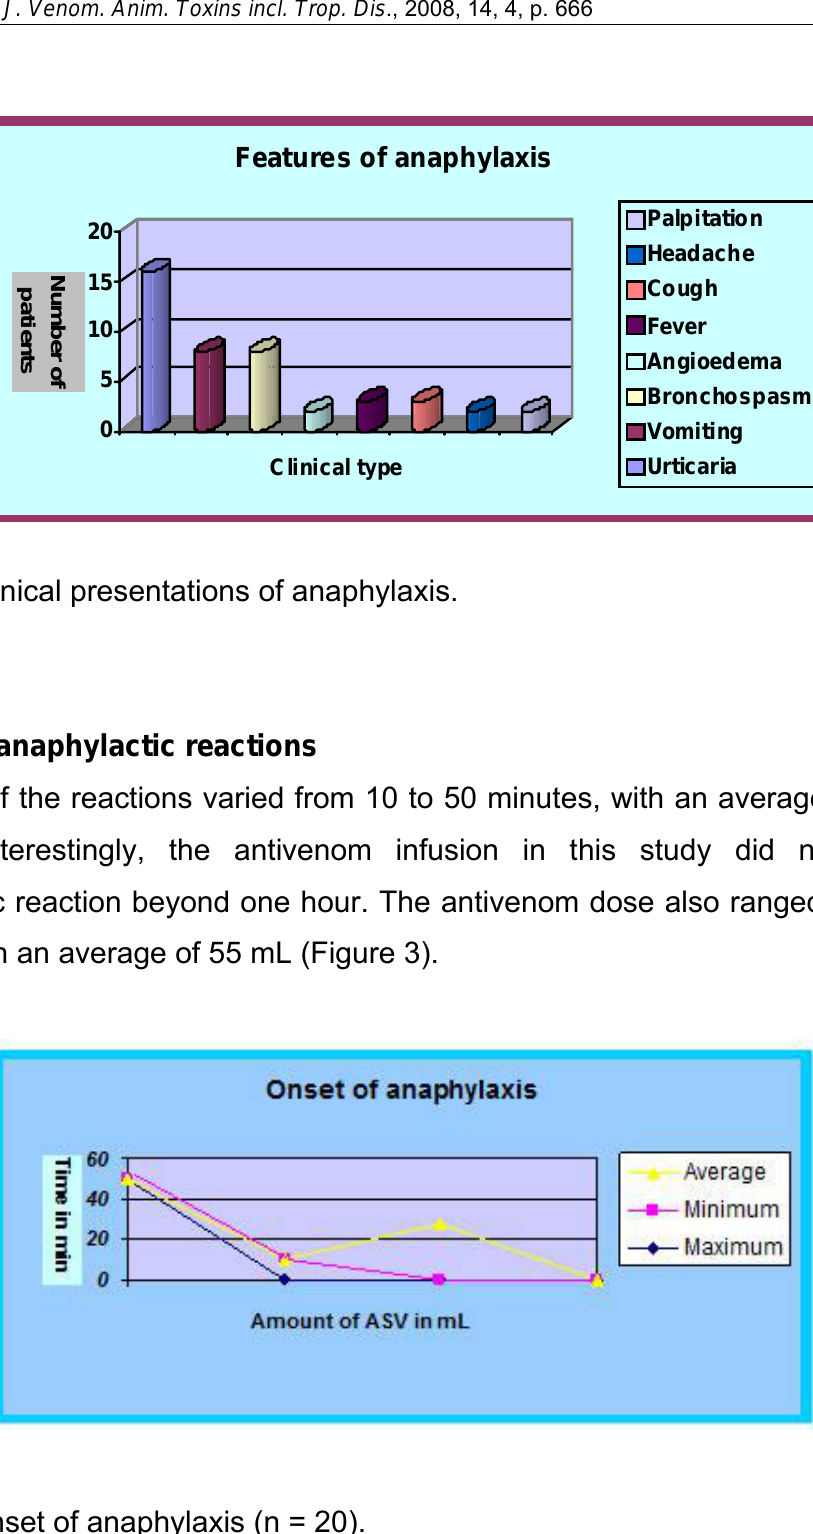
Figure 3. Onset of anaphylaxis (n =